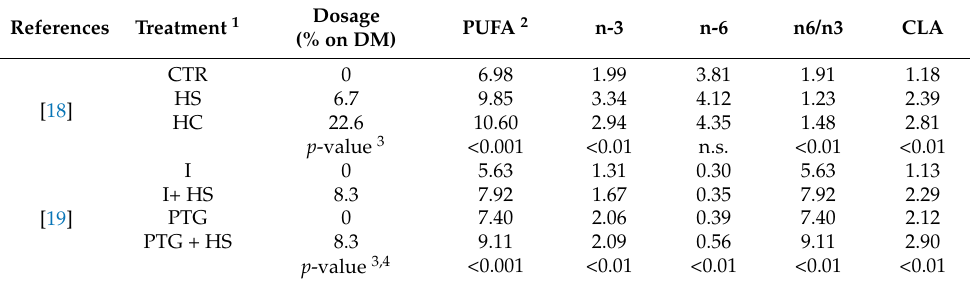
Table 6. Effect of hempseed and derivatives on the fatty acid profile (% of total FA) of ewe